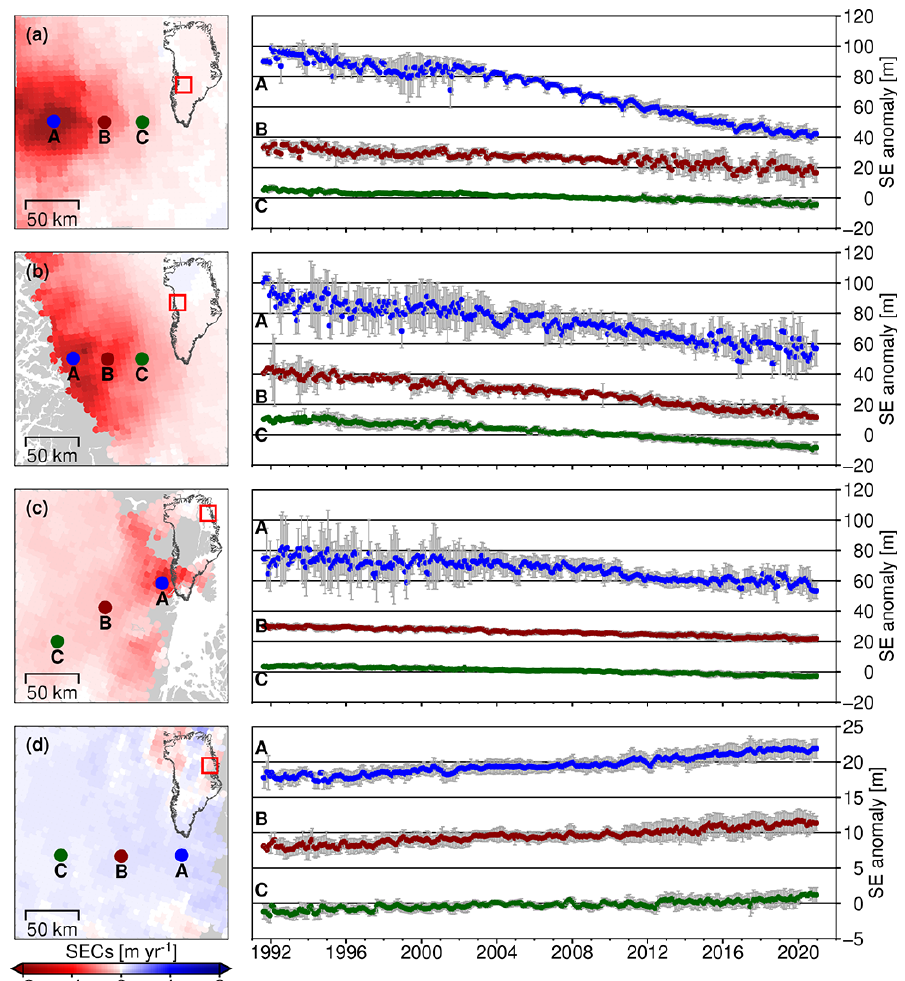
Figure 7. SE anomaly time series near (a) Jakobshavn Isbræ, (b) Upernavik Isstrøm, (c) Zachariæ Isstrøm and Nioghalvfjerdsfjorden Glacier, and (d) King Christian X Land. The locations of the selected points (A, B, and C) are marked in the left-hand maps of elevation change over 1991–2020. The time series and the 1 σ uncertainty ranges for each point are given in the right-hand plots with the time series of points A and B shifted along the SE anomaly axis for better visibility.